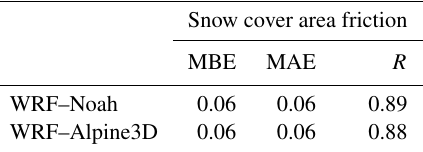
Table 5. WRF–Noah and WRF–Alpine3D mean bias error (MBE), mean absolute error (MAE) and correlation coefficient ( R ) for sim- ulated snow cover area fractions for the three snow seasons.